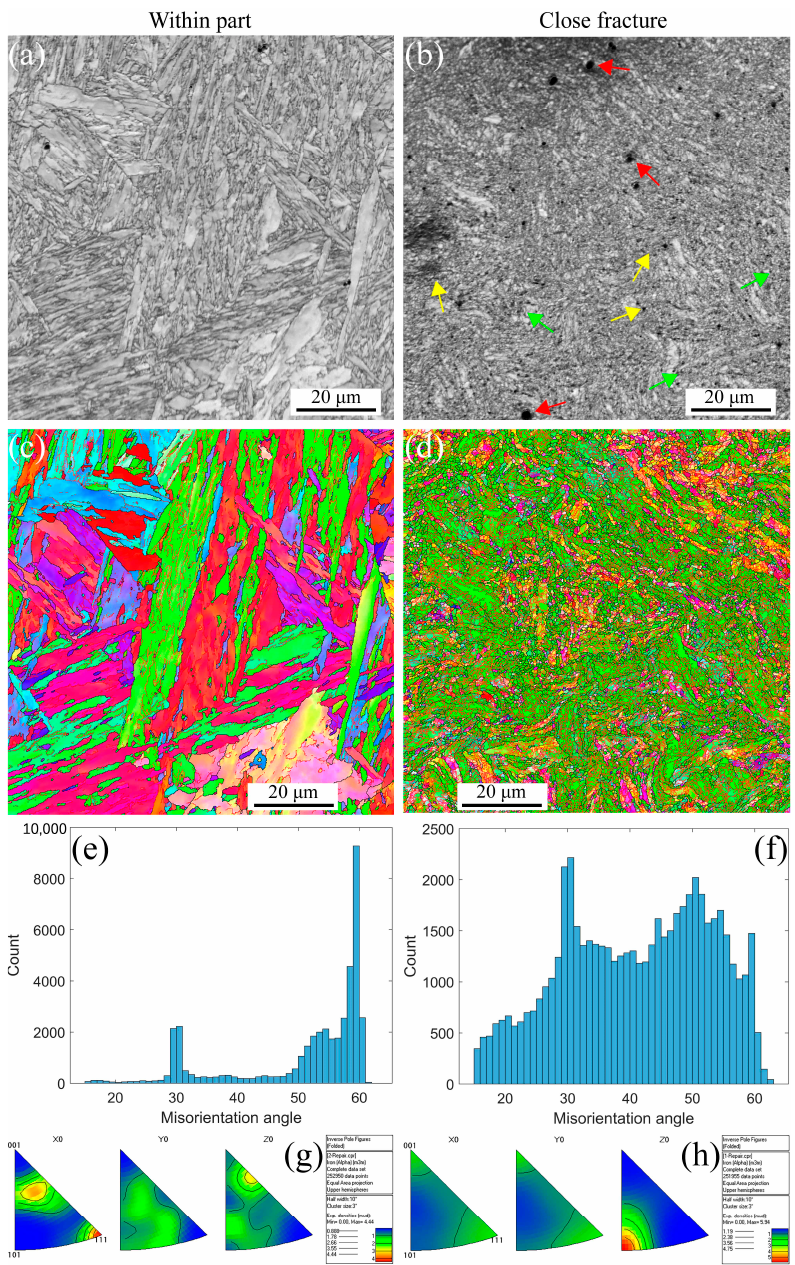
Figure 7. EBSD maps under different strain gradients at the strain rate of 5 × 10 − 3 s − 1 under 630 ◦ C (Red arrows indicate voids within the grain and along the line, green arrows indicate shrinking microstructures, and yellow arrows point to voids and shrinking cracks). ( a , b ) IQs; ( c , d ) IPFs; ( e , f ) misorientation angles; and ( g , h ) inverse polo